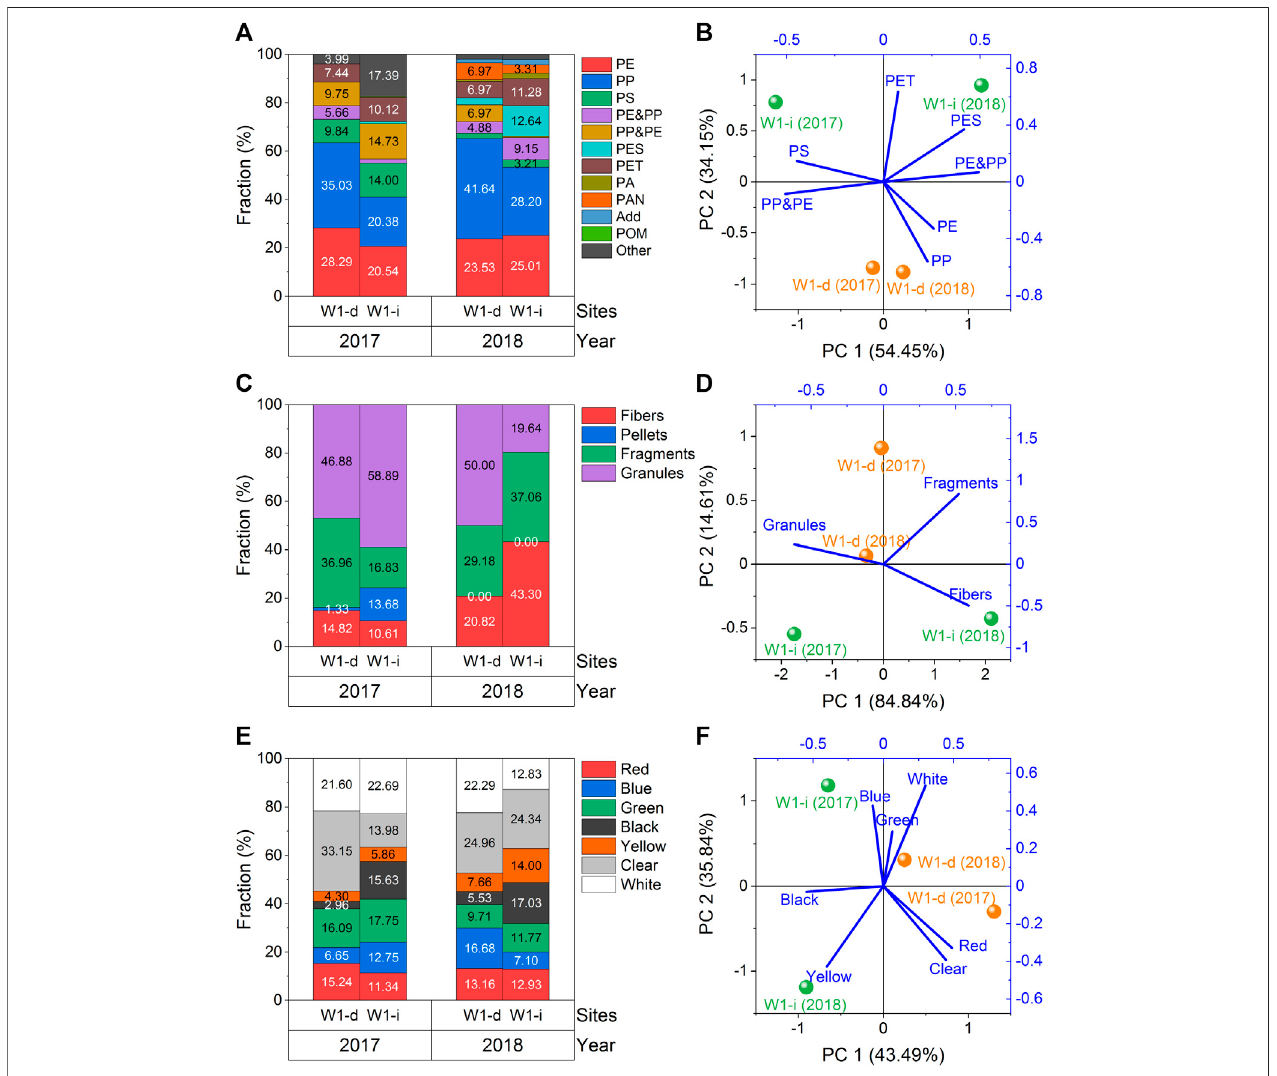
FIGURE 5 | Characteristics of MPs in wastewater from industrial and domestic sources and their biplots of PCA analysis in 2018.